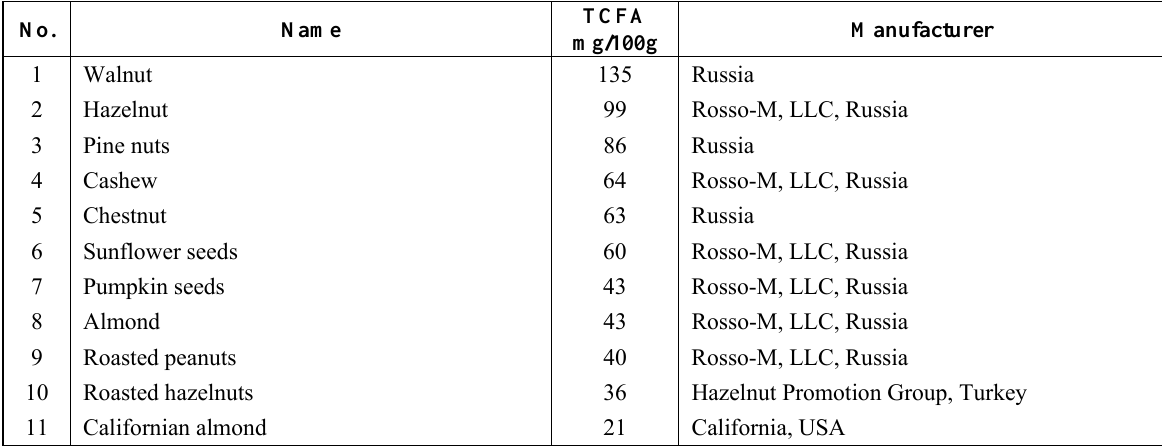
Table 7. Total Content of Fat-Soluble Antioxidants (TCFA) in Nuts and Seeds (standard - gallic